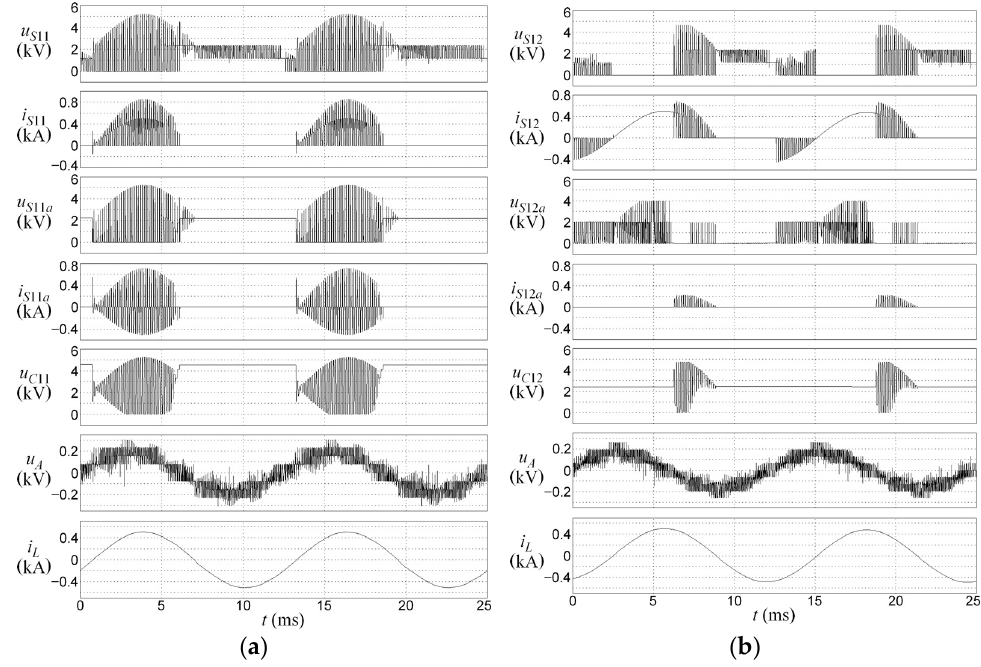
Figure 15. Waveforms during two output frequency periods when the power factor is equal to ( a ) 0.87, and ( b ) 0.089 (motor idle); u A , i L —motor phase voltage and current, respectively; modulation depth factor is equal to 0.85.